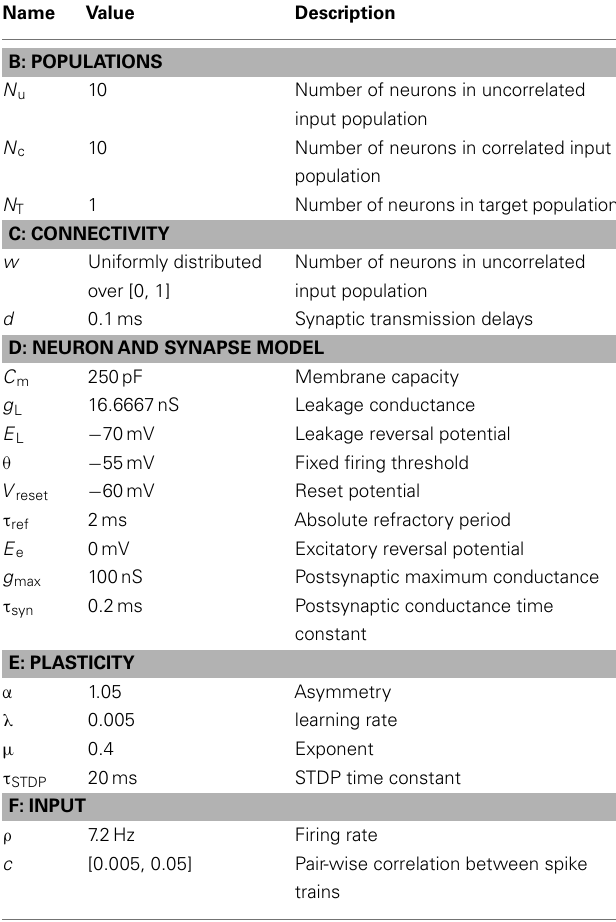
The categories refer to the model description in Table 7